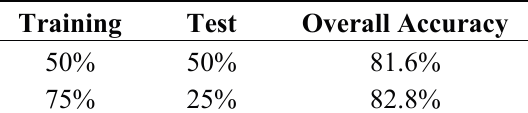
Table 6. Overall classification accuracy obtained using 100 cross-validation iterations and different percentages of training and test data.